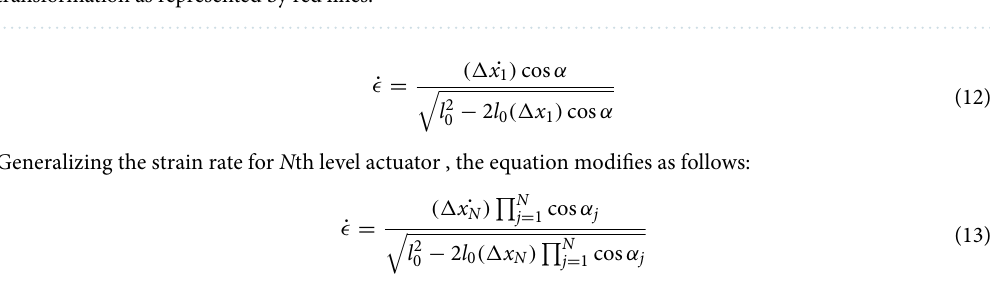
Figure 8. All the n unipennate structure ( n = 6 in this figure) have been connected in series with V in as the input voltage. Stage I: schematic of SMA wires in a bipennate configuration under zero voltage condition; Stage II: depicts the structure under actuation where the SMA wires have contracted because of the reverses transformation as represented by red